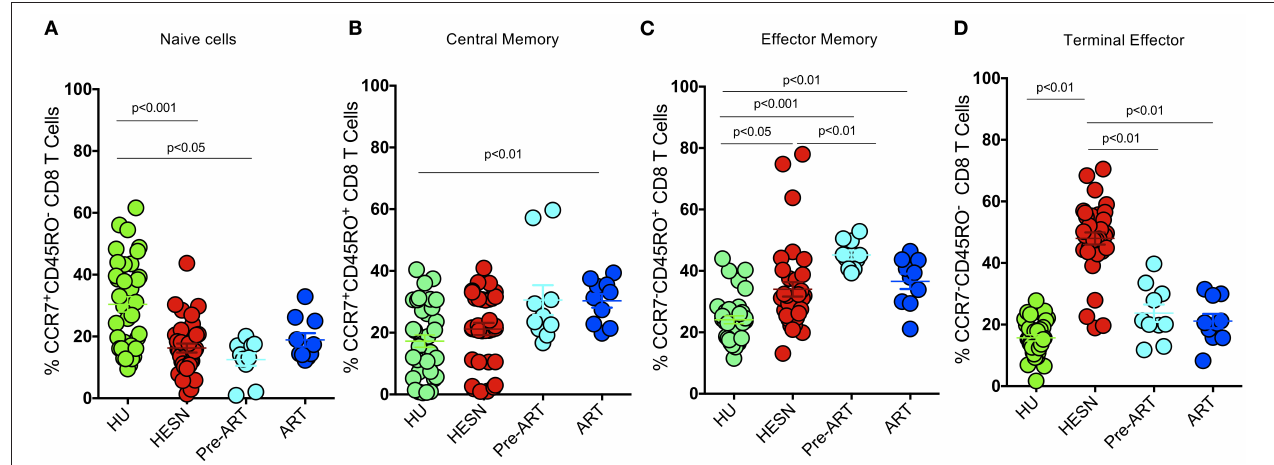
FIGURE 1 | Elevated memory CD8 + T cells in HIV-1 exposed seronegative women. Graphical representation of the % frequency of CD8 + memory T cell subsets defined using CCR7 and CD45RO in the study groups (HESN— N = 35, HIV + ART + – N = 10, HIV + ART − – N = 10, and HU— N = 35). (A) Data showing the cumulative frequency of CCR7 + CD45RO + Central memory CD8 + T cells in the HESN, HIV + ART + , HIV + ART − and HU groups. (B) Data showing the cumulative frequency of CCR7 − CD45RO + Effector memory CD8 + T cells in the HESN, HIV + ART + , HIV + ART − , and HU groups. (C) Data showing the cumulative frequency of CCR7 + CD45RO − naïve CD8 + T cells in the HESN, HIV + ART + , HIV + ART − , and HU groups. (D) Figure showing the cumulative frequency of CCR7 − CD45RO − Terminal effector memory CD8 + T cells in the HESN, HIV + ART + , HIV + ART − , and HU groups. The scatter dot plots summarize the % frequency of total memory T cells (median, 1st, and 3rd quartiles). p- values were calculated using the K-Wallis test. Sub-group analysis was performed using Dunn’s test. (HESN, HIV exposed seronegative; HIV + ART + , HIV-infected women on ART; HIV + ART − , HIV-infected women naïve to ART; HU, HIV unexposed seronegative controls).